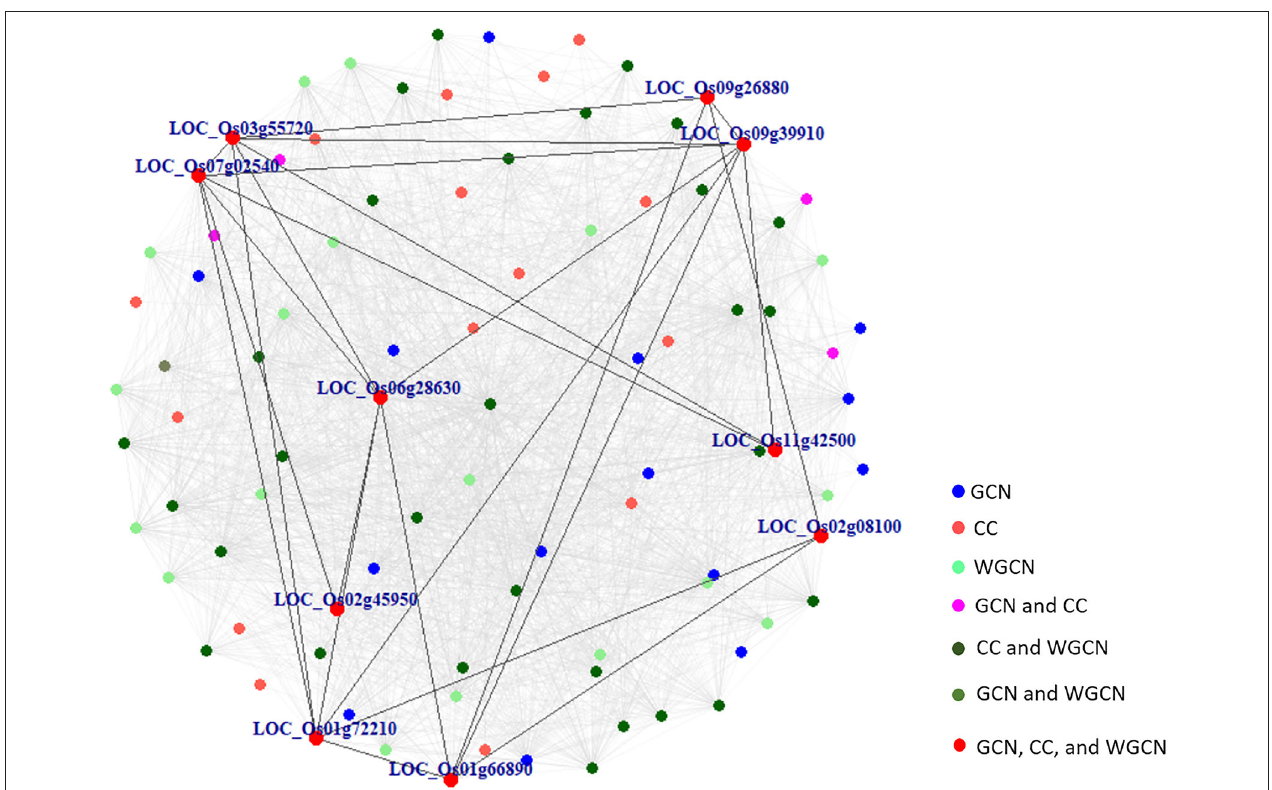
FIGURE 7 | The co-expression network of 92 marker genes identified by GCN, CC, and WGCN. Ten genes in red were detected by all methods and the connections among them were shown in darked lines. All gray lines represent the connections among these 92 marker